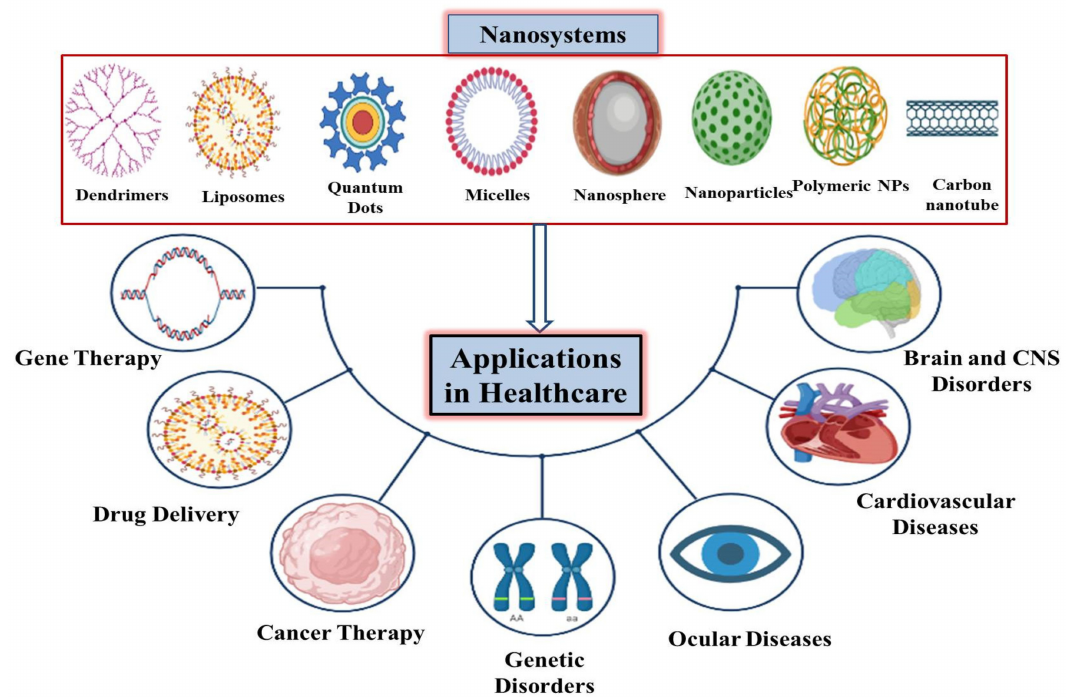
Figure 1. Schematic presentation of applications of various nanosystems in allied healthcare